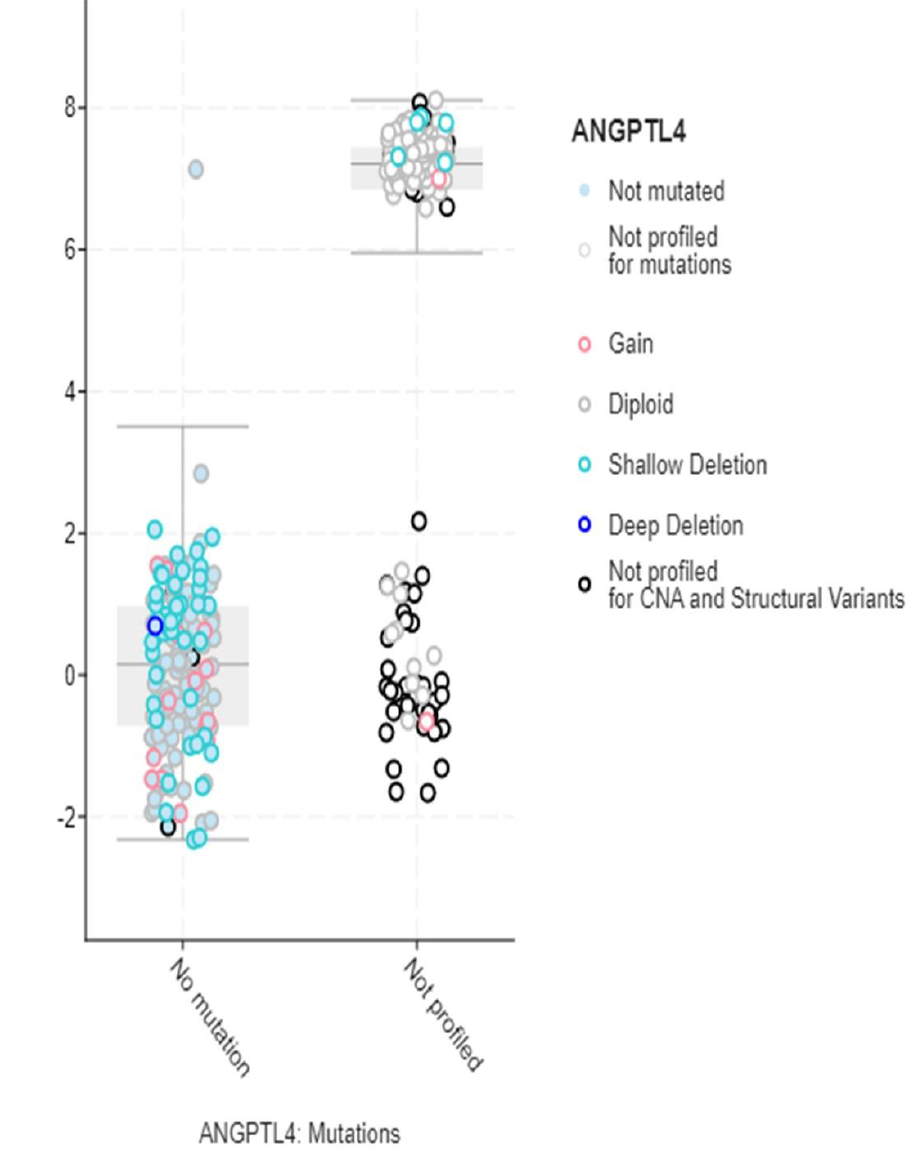
Figure 5. mRNA expression vs. ANGPTL4.